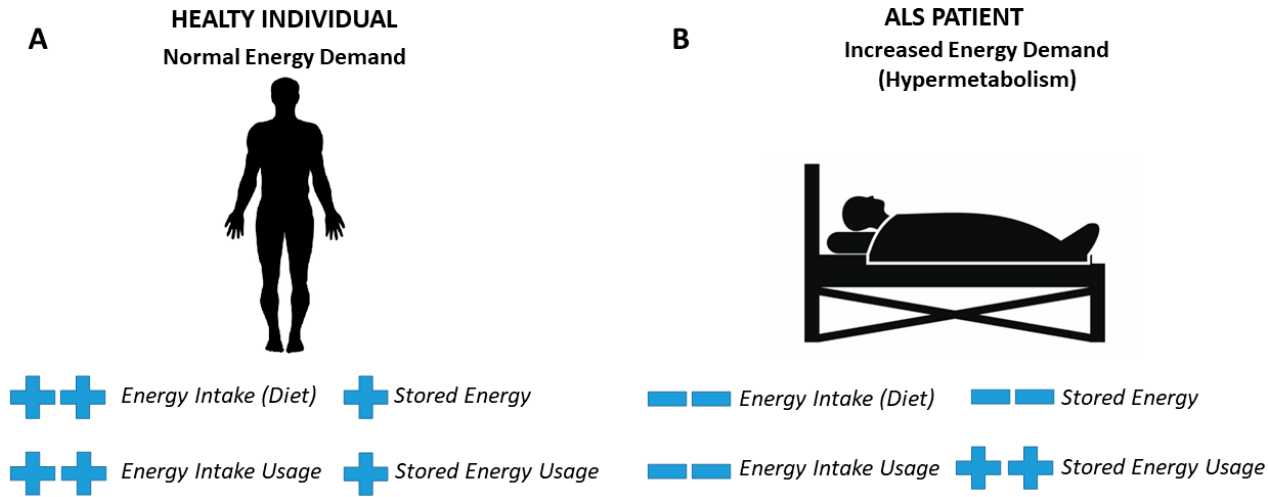
Figure 2. Metabolic differences between a healthy individual and a patient affected by Amyotrophic Lateral Sclerosis (ALS). ( A ) In healthy individuals, during periods of normal energy demand, energy intake is used to meet energy demands,